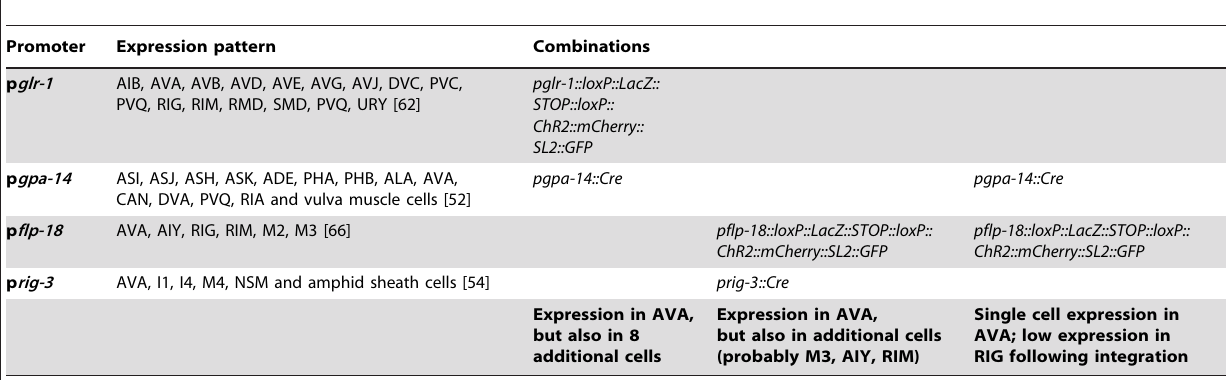
Table 4. Promoter combinations used for AVA specific ChR2 expression (Cre-lox